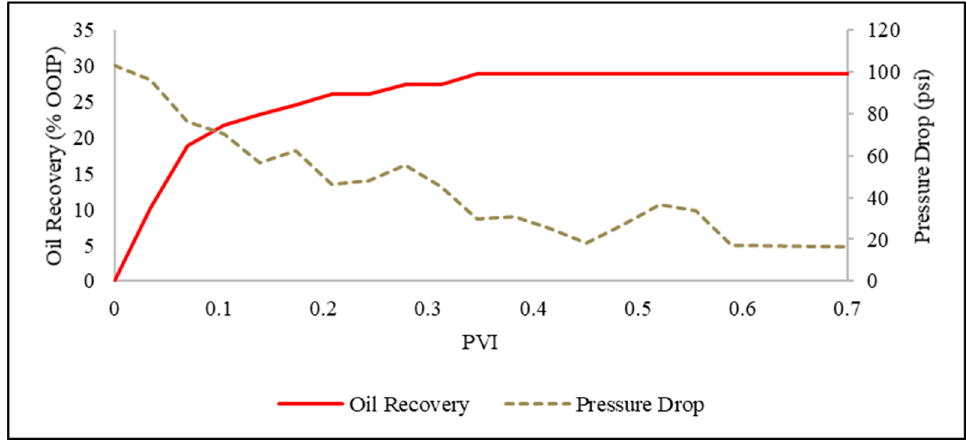
Figure 14. Oil recovery and pressure response for Clinton sandstone immiscible CO 2 flood.